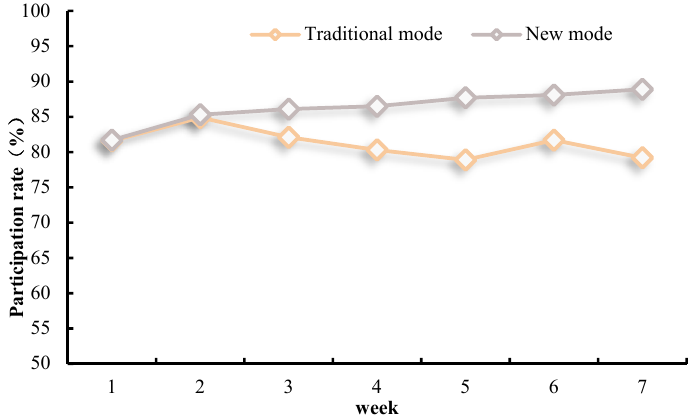
Figure 6. Changes of students’ classroom participation rate in 7 weeks under the two models.